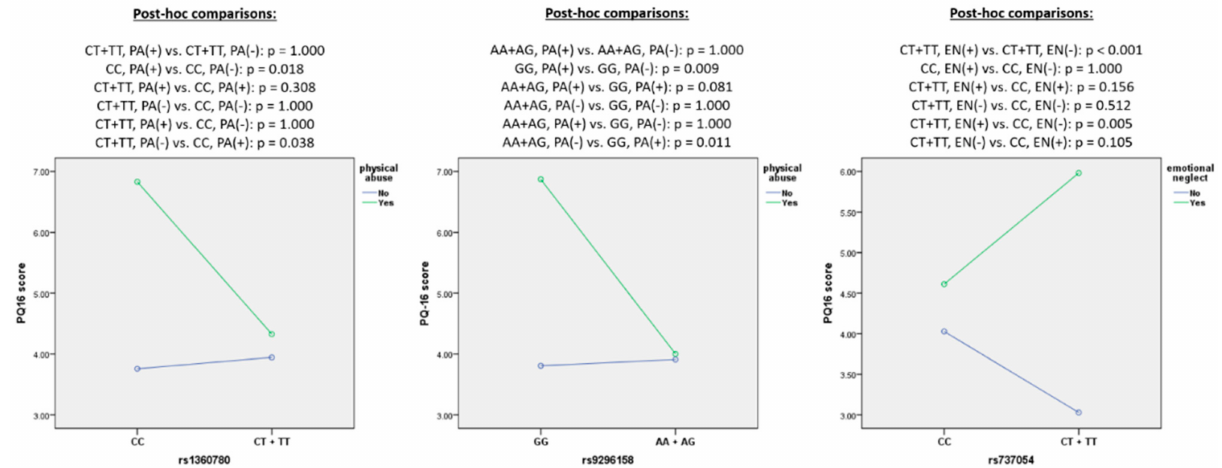
Figure 1. Interactive effects of the FKBP5 genotype and TLEs on the PQ-16